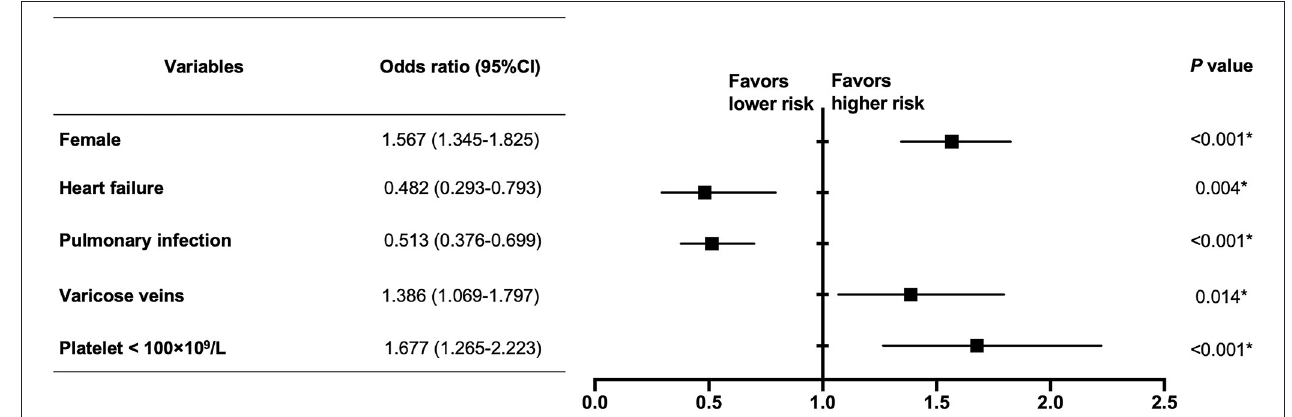
FIGURE 2 | Multivariate analysis of clinical factors related with syncope in PE patients. In the multivariate analysis, female (OR 1.567, 95% CI 1.345–1.825, P < 0.001), varicose veins (OR 1.386, 95% CI 1.069–1.797, P = 0.014), and platelet < 100 × 10 9 /L (OR 1.677, 95% CI 1.265–2.223, P < 0.001) were independent risk factors related with syncope in PE, while heart failure (OR 0.482, 95% CI 0.293–0.793, P = 0.004) and pulmonary infection (OR 0.513, 95% CI 0.376–0.699, P < 0.001) were protective factors. *The difference is statistically significant.